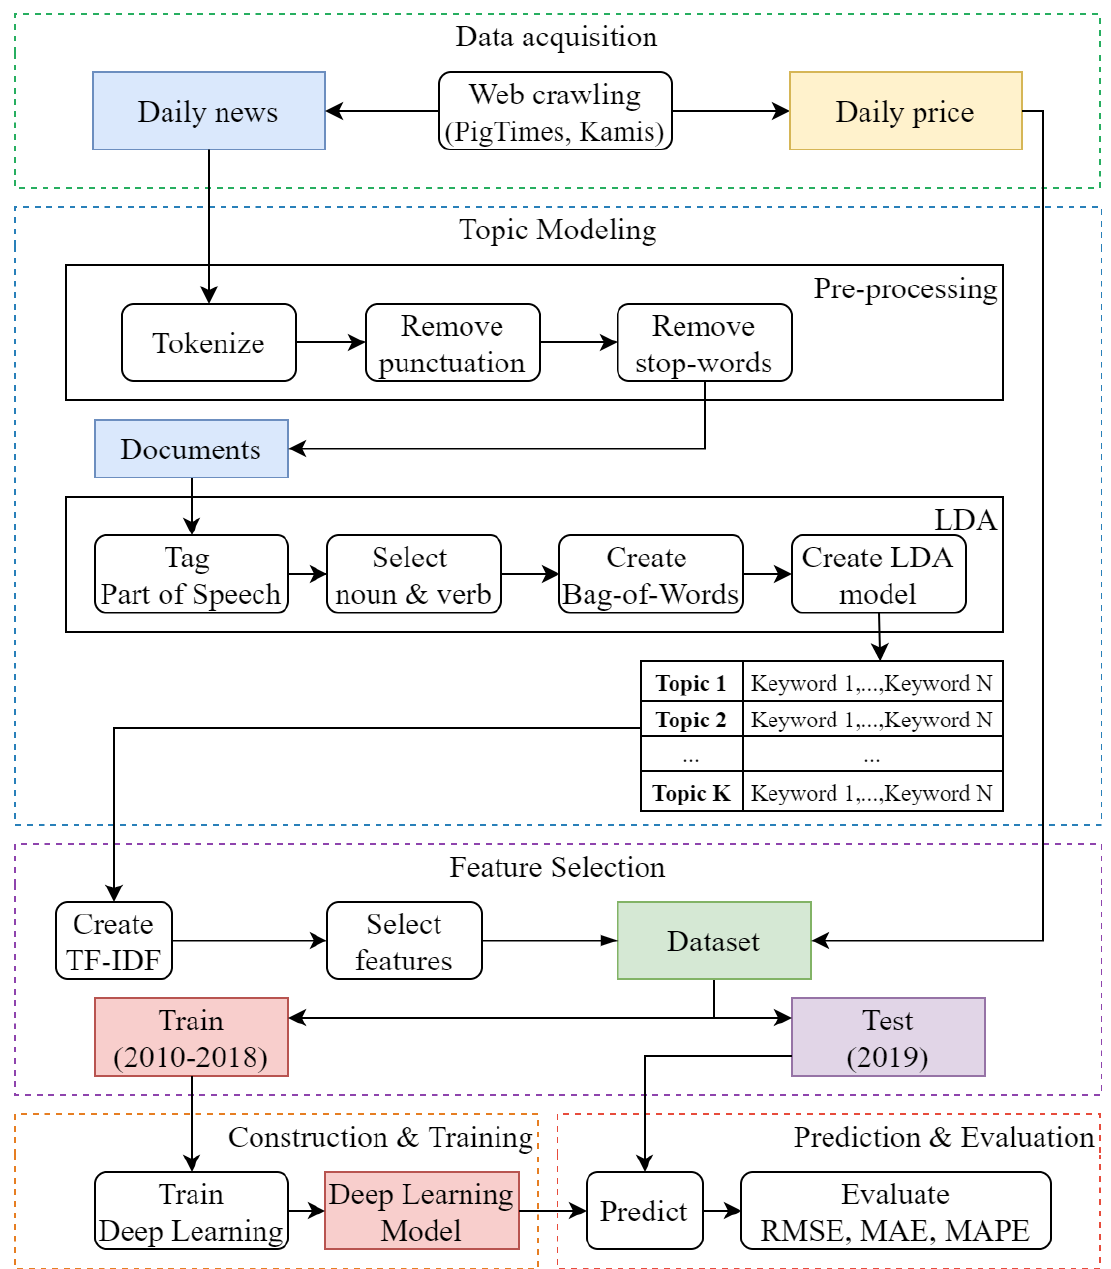
Figure 2. Overall flow of the proposed method. Here, RMSE: Root Mean Squared Error; MAE: Mean Absolute Error; MAPE: Mean Absolute Percentage Error. Table 2. The details of collected dataset.